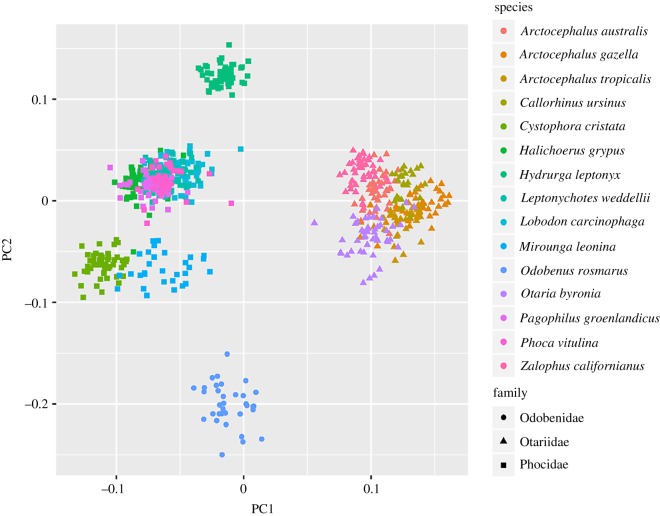
Results from the PCA displaying distribution of specimens across the PC1 (33.5% of variation) × PC2 (20% of variation) morphospace. Whereas familial identity of specimens is marked by symbols (i.e. circles for odobenids, triangles for otariids and squares for phocids), species are differentiated by the colour scheme on the right.